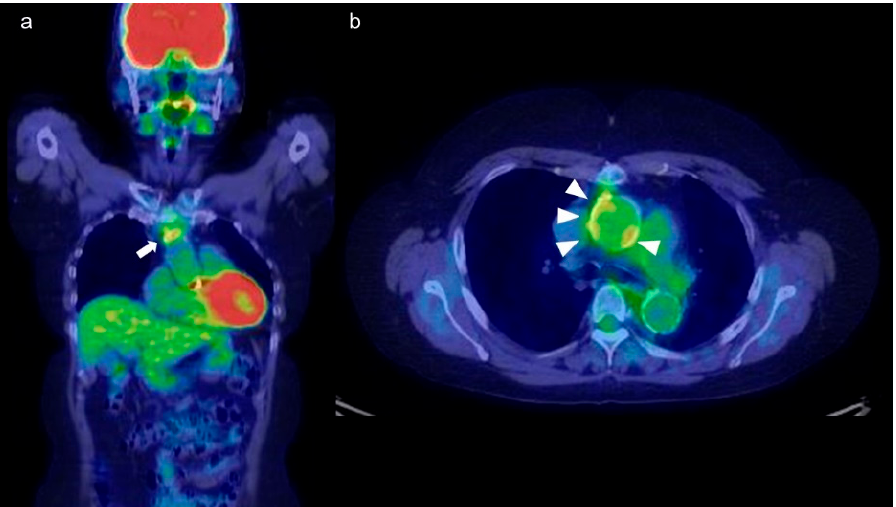
Figure 4. ( a ) Coronal and ( b ) axial view of FDG-PET-CT of a 55-year-old woman with TA. FDG is abnormally accumulated in the vessel wall of the ascending aorta (a: arrow, b: